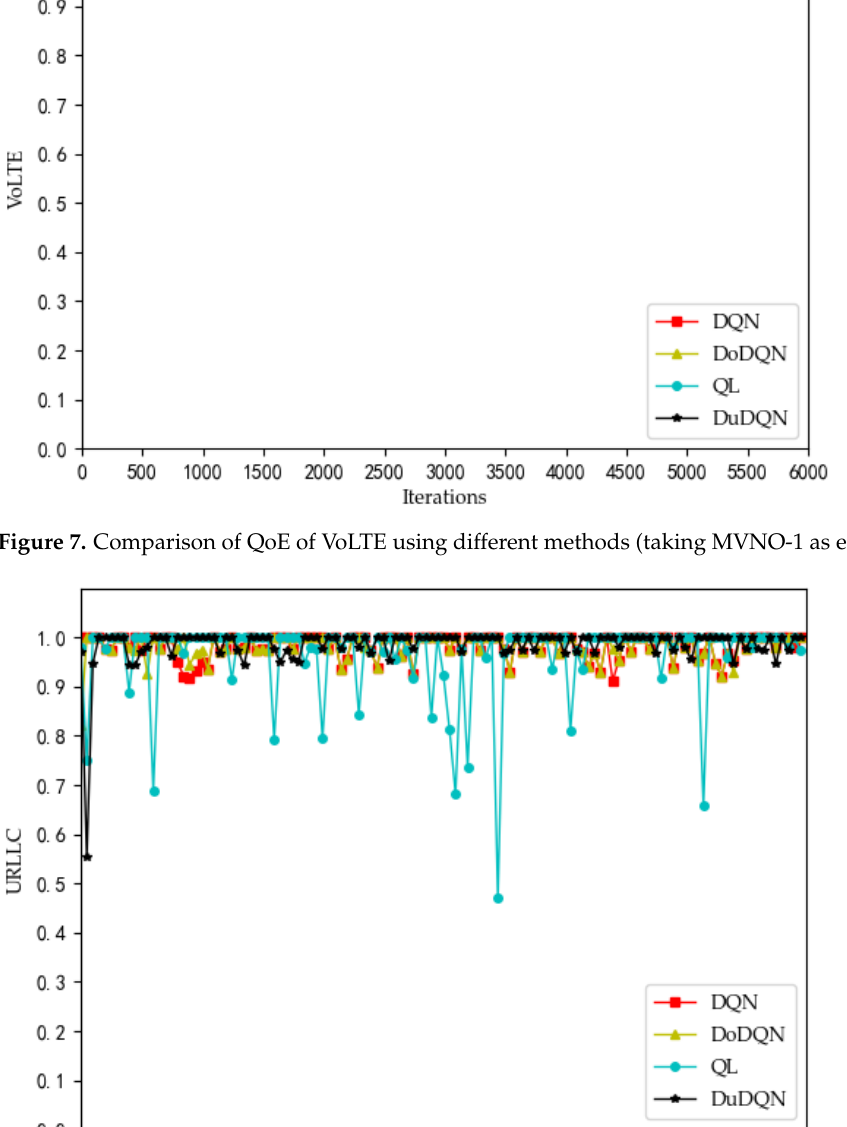
Figure 8. Comparison of QoE of URLLC using different methods (taking MVNO-1 as examples).